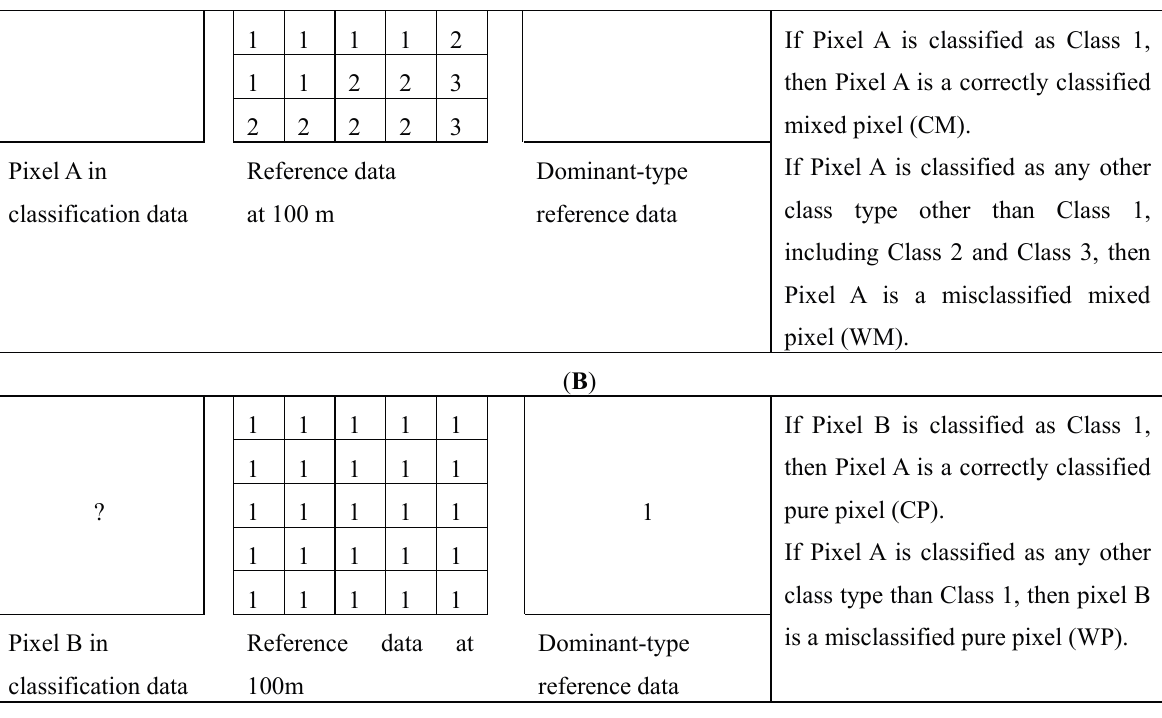
Figure 3. Types of pixels in the aggregated classification data. ( A ) Distribution of pure and mixed pixels in the dominant-type reference data. ( B ) Mixed pixel. ( C ) Pure